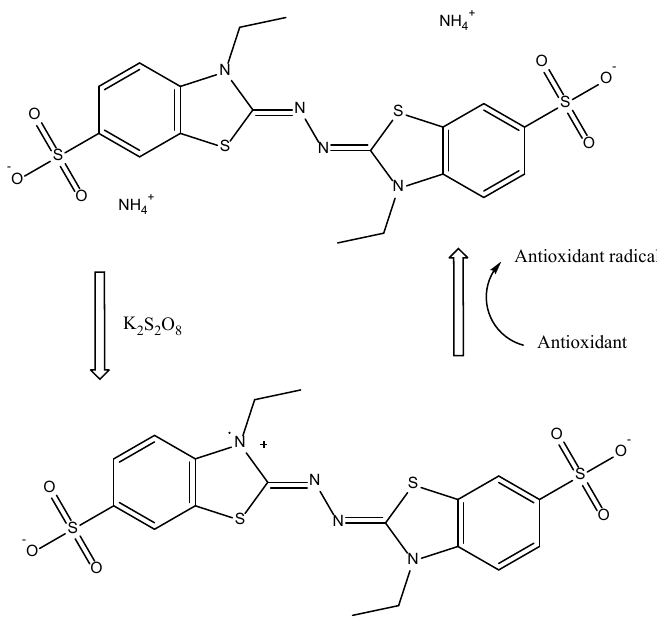
Figure 13. Proposed ABTS mechanism